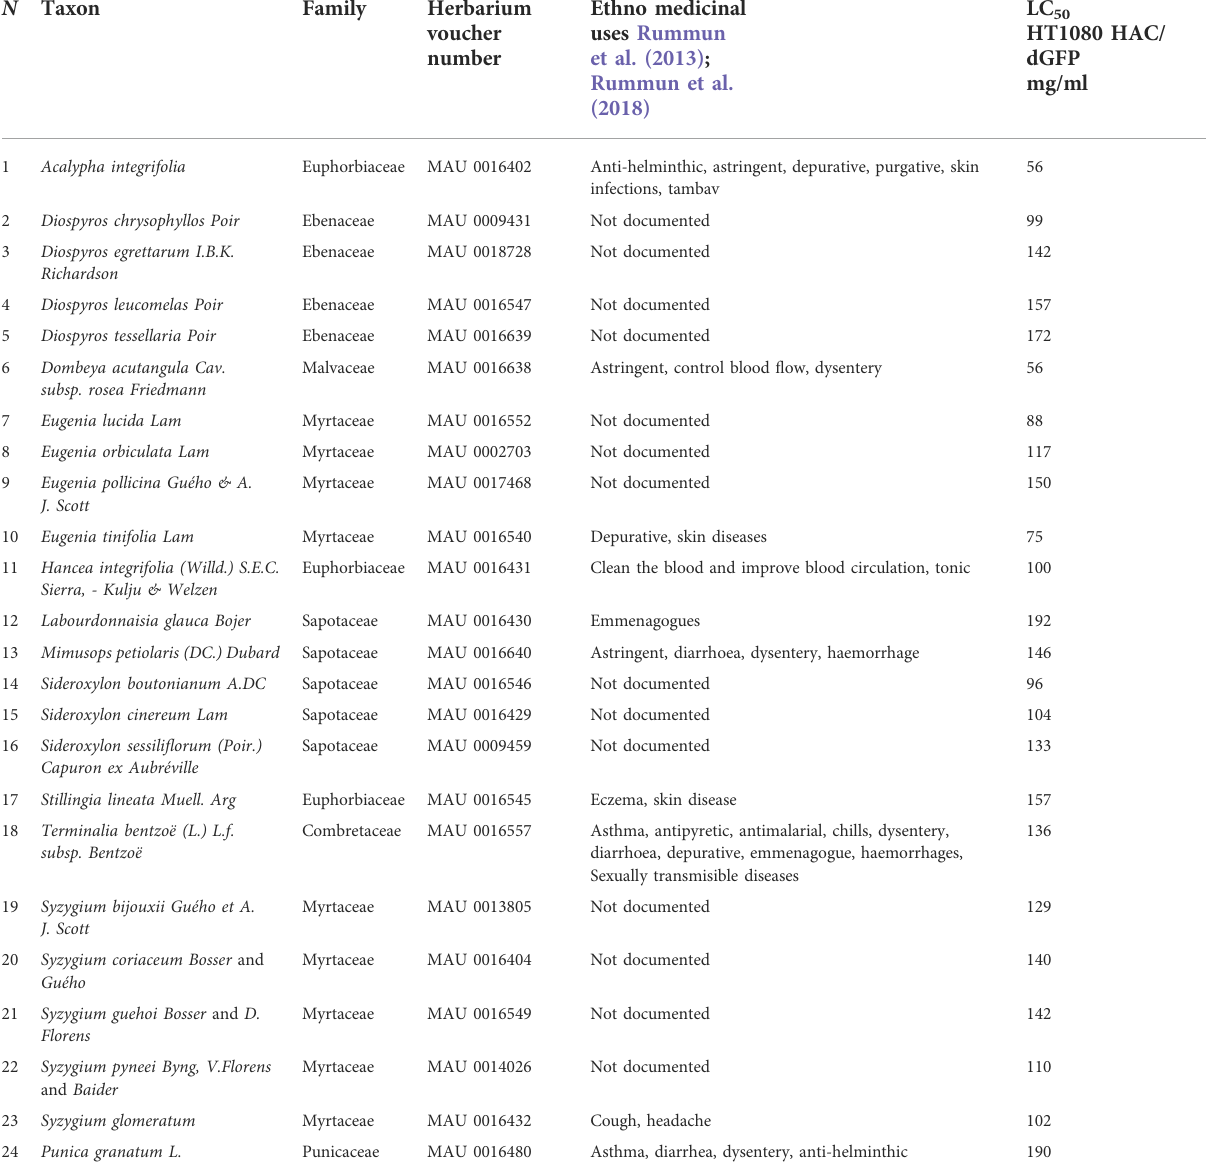
TABLE 1 Natural products and their extracts used in this